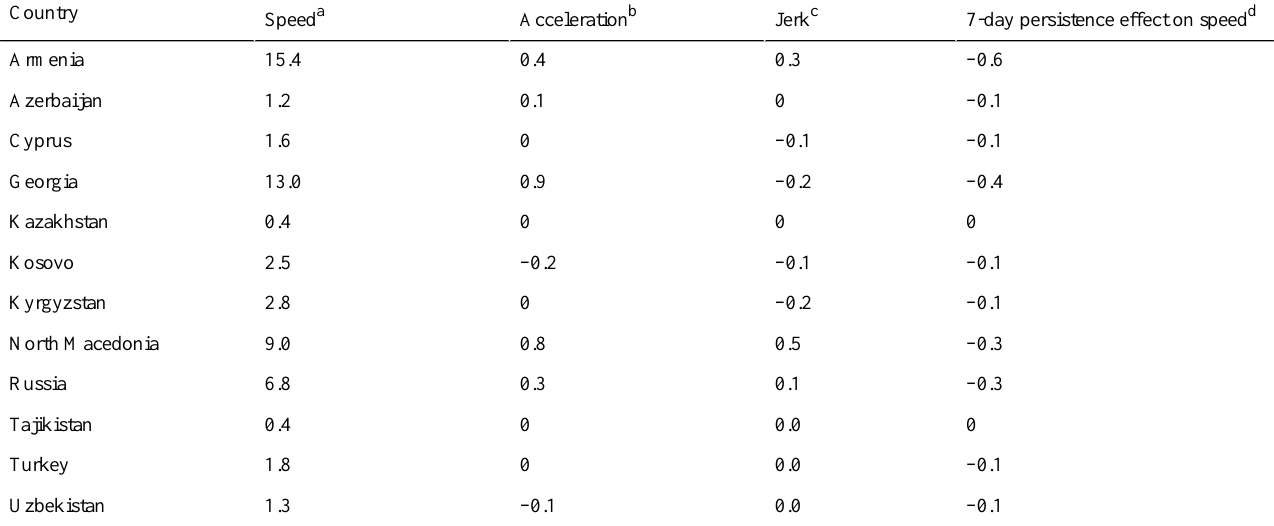
Table 4. Novel surveillance metrics for the week of September 30 to October 6,